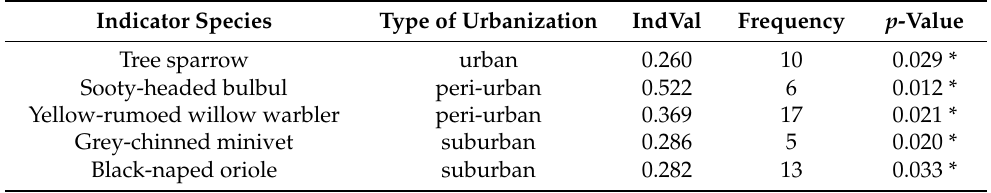
Table 4. Bird species indicate different urbanization types of mountain park. We indicated the species that obtained the highest correlation, the value of indicator species (IndVal), and the statistical significance of the association ( p -value, * = p < 0.05;). Indicator Species Type of Urbanization IndVal Frequency p -Value Tree sparrow urban Yellow-rumoed willow warbler